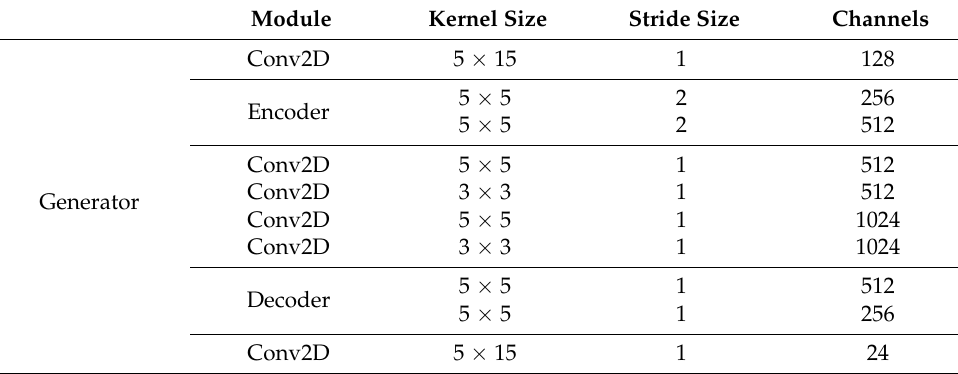
Table 1. Parameter setting of BSEGAN-SI